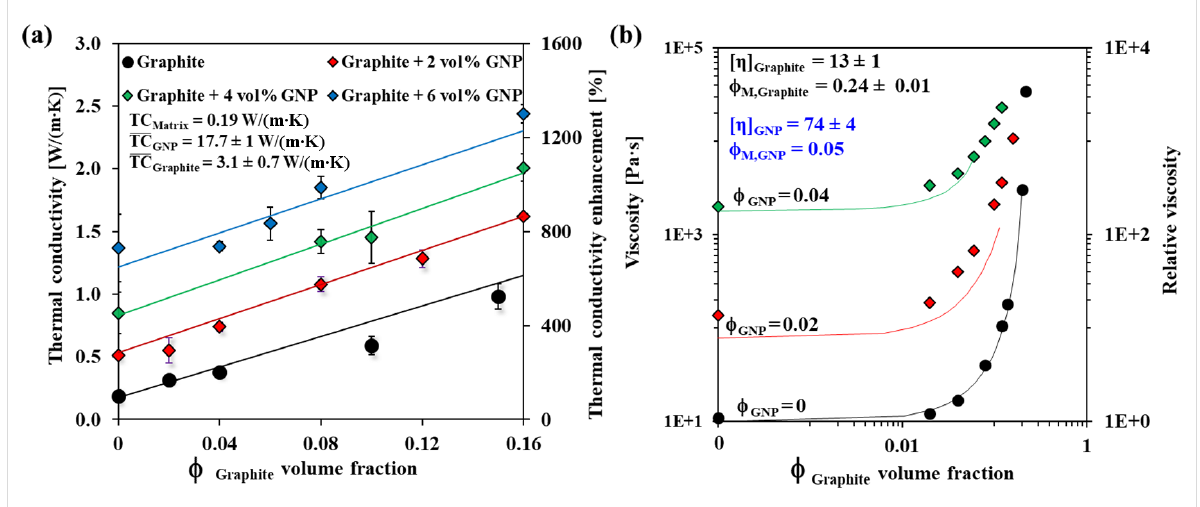
Figure 4: Thermal conductivity (a) and viscosity (b) of hybrid composites (at constant shear rate 0.1 [1/s], T = 25 °C) as a function of the graphite volume fraction. Each color represents a different constant GNP volume percent. The lines in (a) are fits to the ROM model (Equation 1), and those in (b), to the modified K–D model (Equation 2). The fitting parameters are shown in each